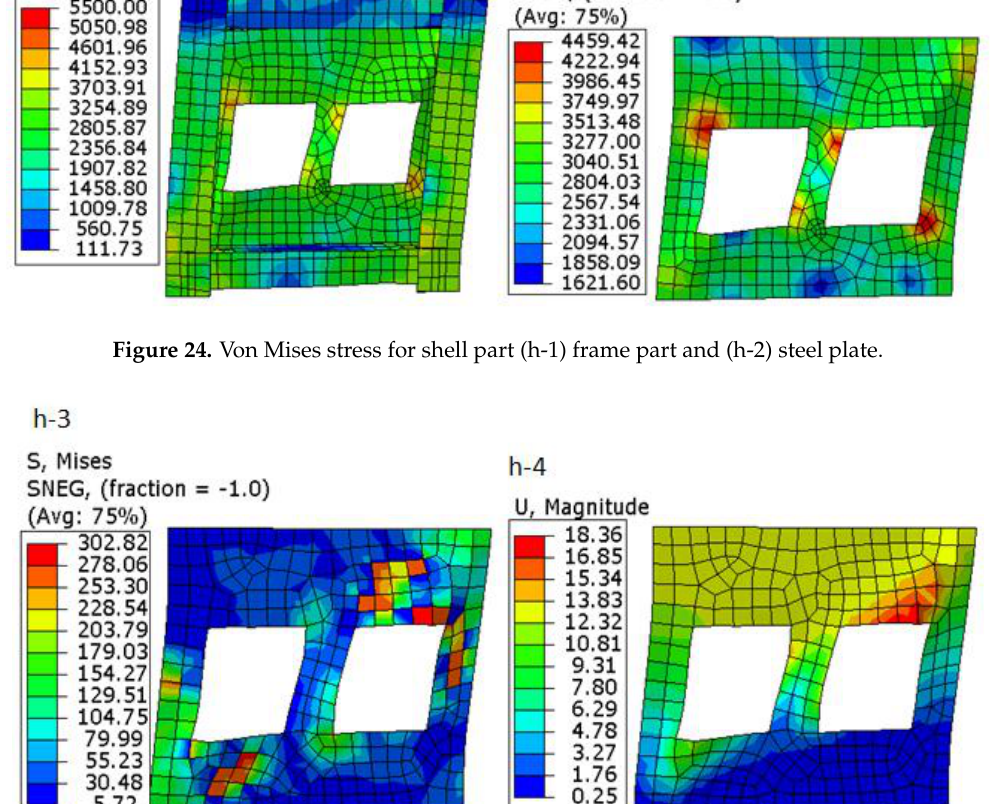
Figure 25. Von Mises stress and displacement for concrete part (h-3) stress and (h-4) displacement.